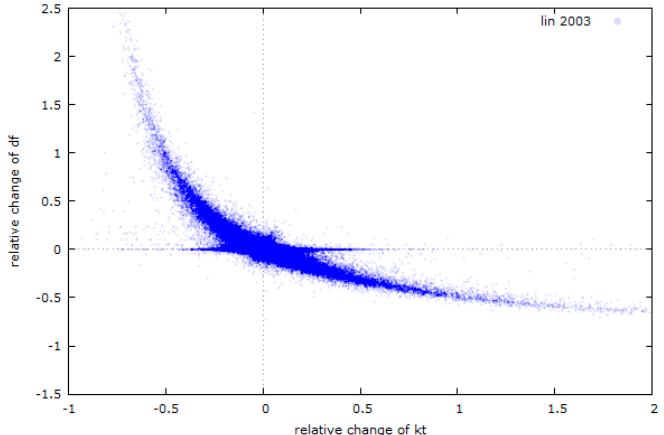
Figure 5. Scatter plot of the relative changes of the diffuse fraction over the relative changes of the clearness index for Lindenberg, Germany, 2003. This strong relation is very valuable for modelling a realistic behaviour of the diffuse fraction over the day, since it depends highly on the behaviour of kt . The area where the change of df is 0 while kt shows relatives changes between − 0.5 and 0.5, i.e., df is changing while kt is not, indicates days with movement of broken clouds, the reflection on which couses the measured global irradiance to change rapidly without changing its diffuse